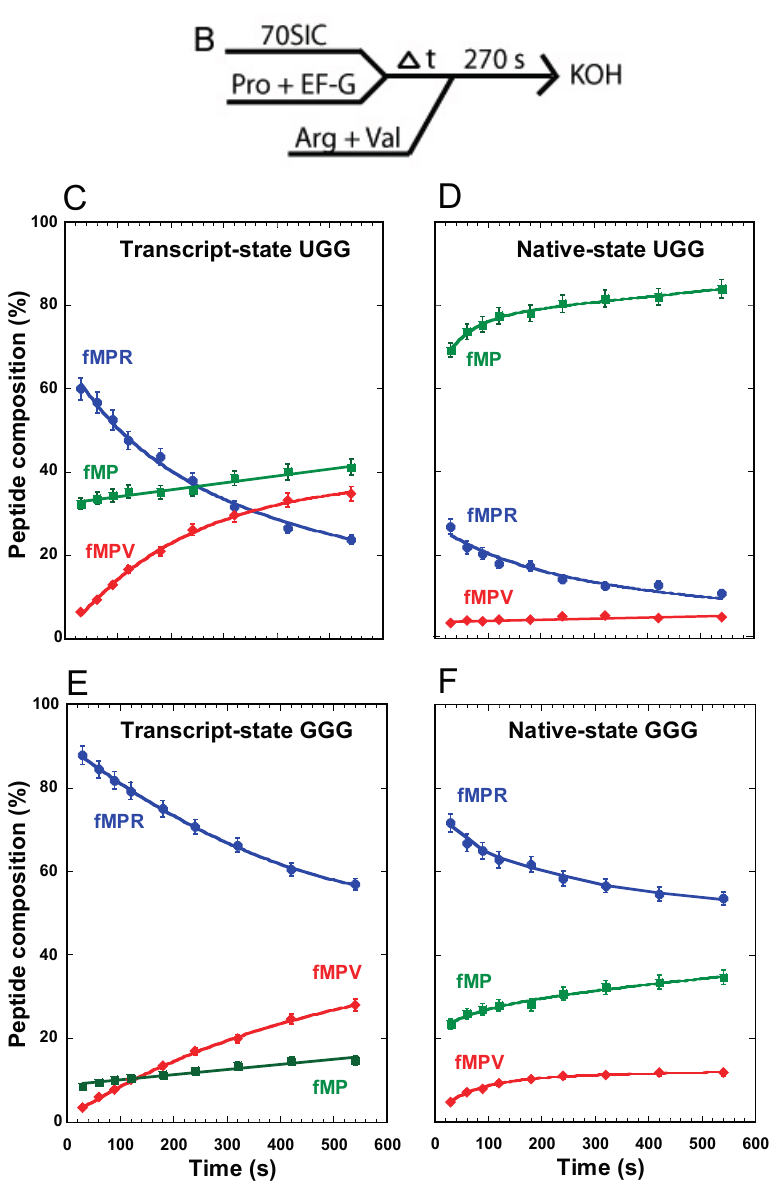
Figure 2. Analysis of forward +1 frameshifts of tRNA Pro from a stalled ribosome complex. ( A ) The template mRNA sequence, showing the 5 ʹ -Shine Dalgarno sequence (underlined), the AUG start codon (italic), and the slippery CCC-C sequence immediately following the start codon; ( B ) The reaction scheme for the conversion from fMP to tripeptides, starting with mixing a 70SIC with the ternary complex of tRNA Pro in the presence of EF-G to form a post-complex with fMP-tRNA Pro in the P-site. After stalling for various time periods, the complex was reacted with ternary complexes of tRNA Arg and tRNA Val for 270 s before being quenched by KOH. The changes in the peptide composition over time for the substrate fMP, the 0-frame product fMPR, and the +1-frame fMPV were monitored for ( C ) the transcript-state of the UGG isoacceptor of tRNA Pro ; ( D ) the native-state of the UGG isoacceptor; ( E ) the transcript-state of the GGG isoacceptor; and ( F ) the native-state of the GGG isoacceptor. Each data point is the average of 3 independent